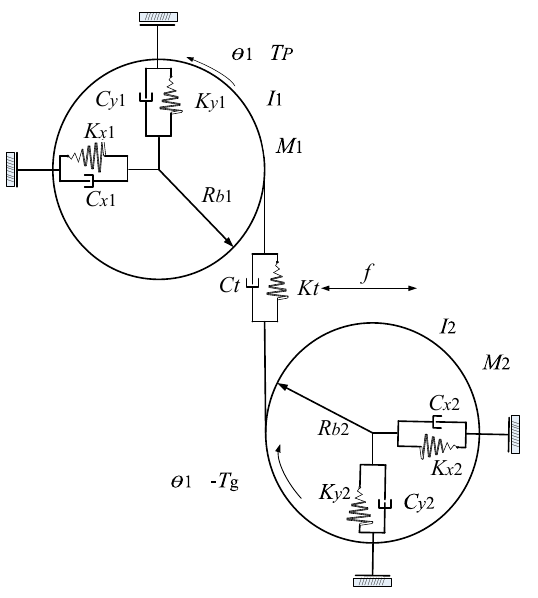
Figure 5. Dynamic model for a gearbox. Table 3. Main parameters of the gear pair.